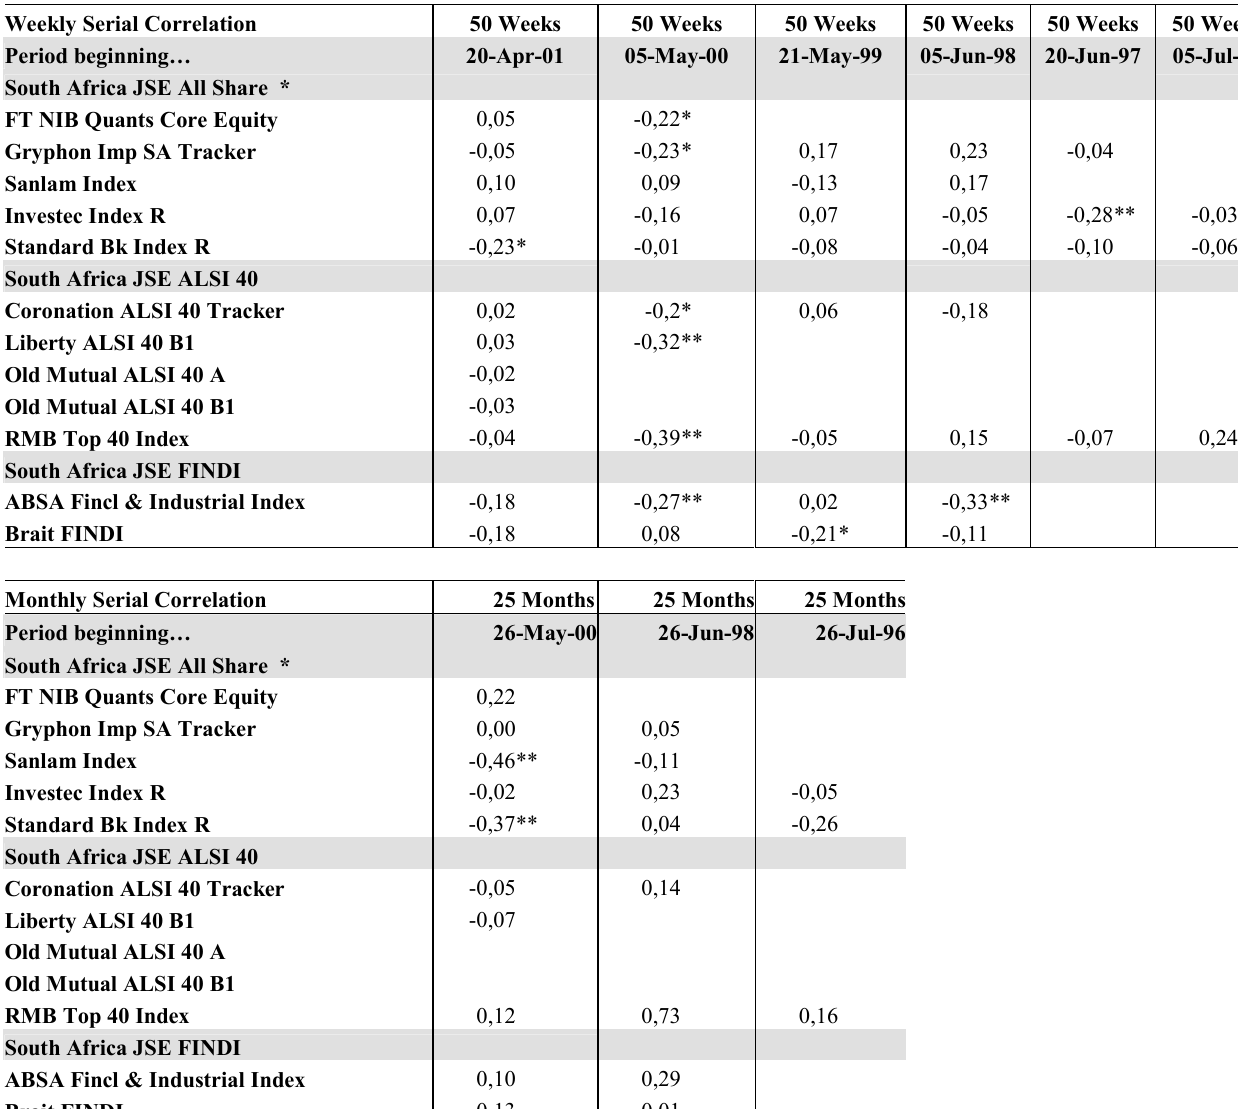
Table 3: Serial Correlation (lag = 3) of each Fund’s TE against its Benchmark for non-overlapping periods Weekly Serial